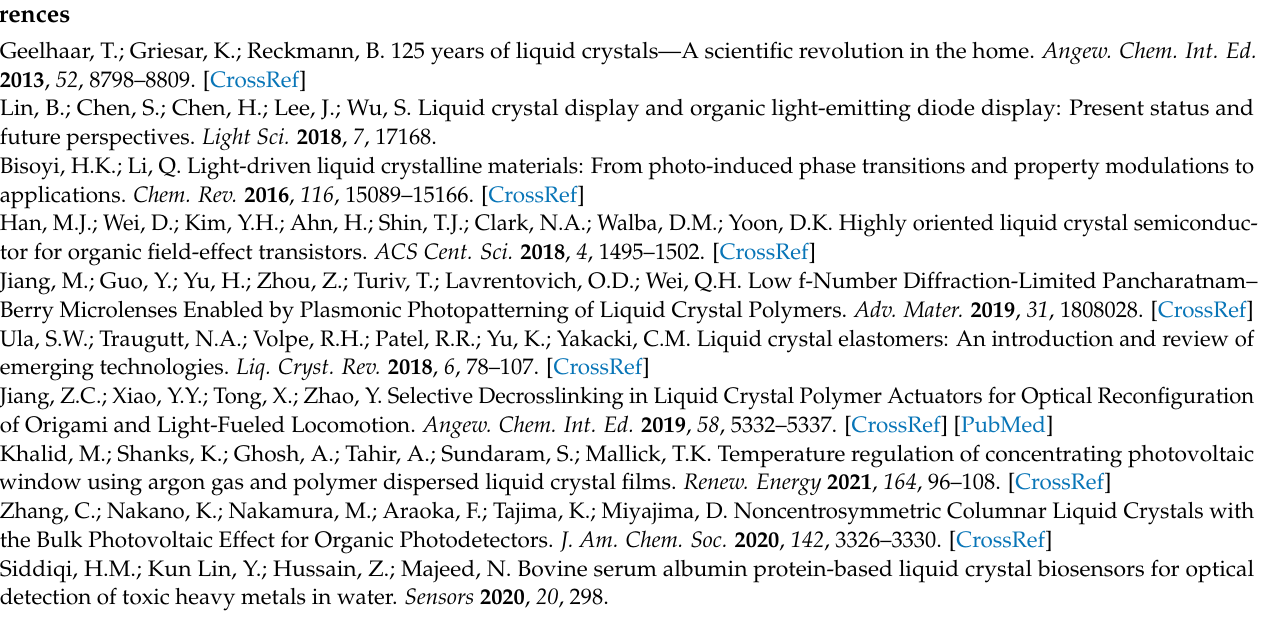
3.d , Figure S3: 1 H NMR of compound 3.e , Figure S4: 13 C NMR of compound 3.e , Figure S5: 1 H NMR of compound 3.f , Figure S6: 13 C NMR of compound 3.f